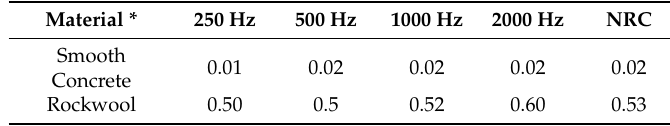
Table 4. Sound absorption coefficients of the noise